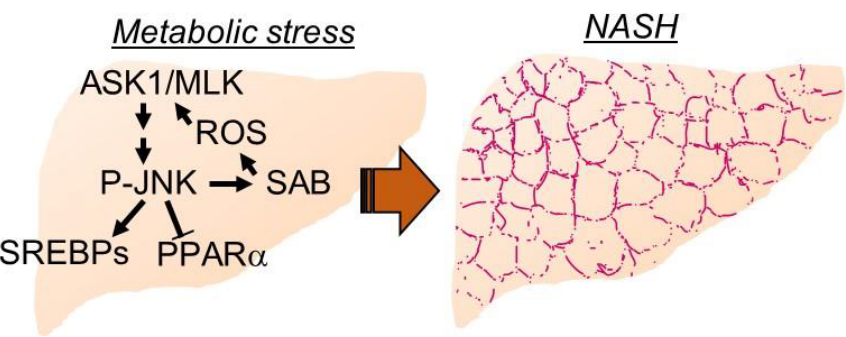
Figure 1. Key mediators of hepatic metabolic stress. Carbohydrate and free fatty acid overload to hepatocytes activate stress kinase cascade to upregulate de novo lipogenesis genes to adapt metabolic stress. Dial-up feedforward activation of stress kinase cascade through P-JNK-SAB interaction attenuates β -oxidation and lipid oxidation genes. Damage signals, receptors, and extracellular vesicles from hepatocytes recruit inflammation, and activate hepatic stellate cells and fibrogenesis.